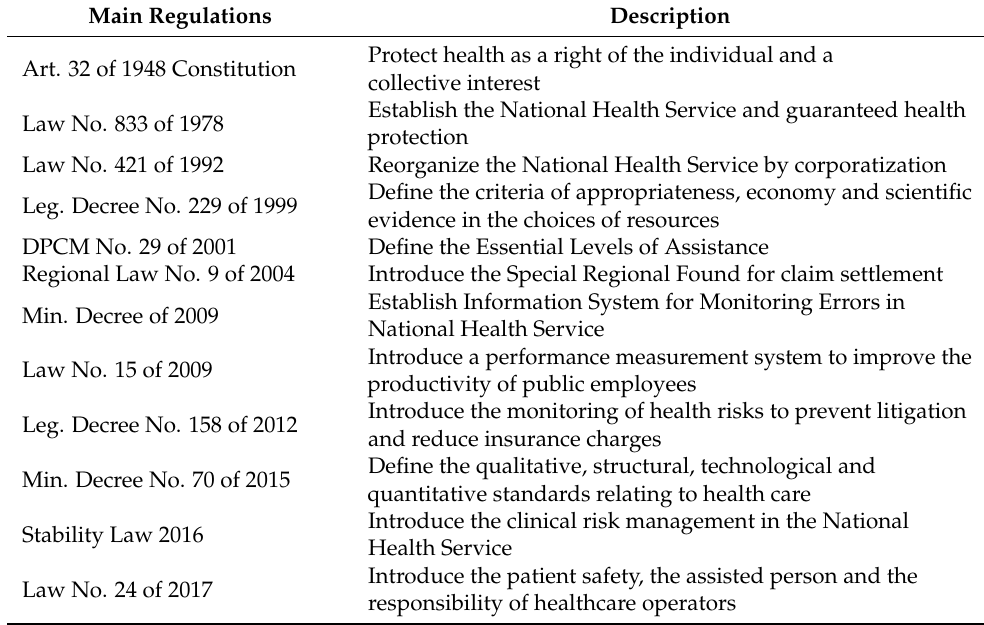
Table 2. Main regulations on National Health Service and Piedmont Heath